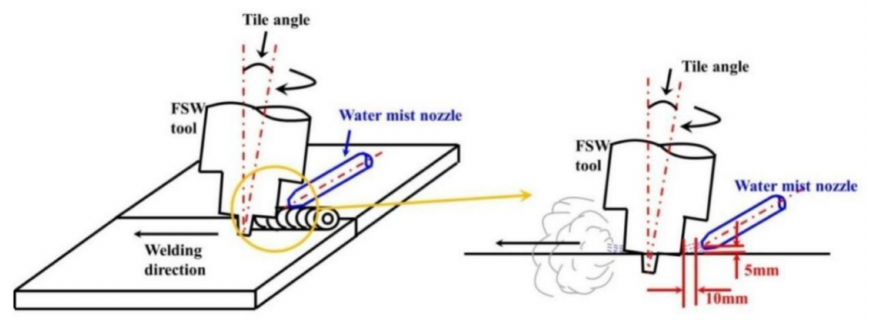
Figure 18. Schematic diagram of FSW with cooling medium on the surface of the workpiece [55]. Table 9. Comparison of the tensile properties of age-hardening aluminum alloy butt joint welded by FSW under normal and externally assisted cooling